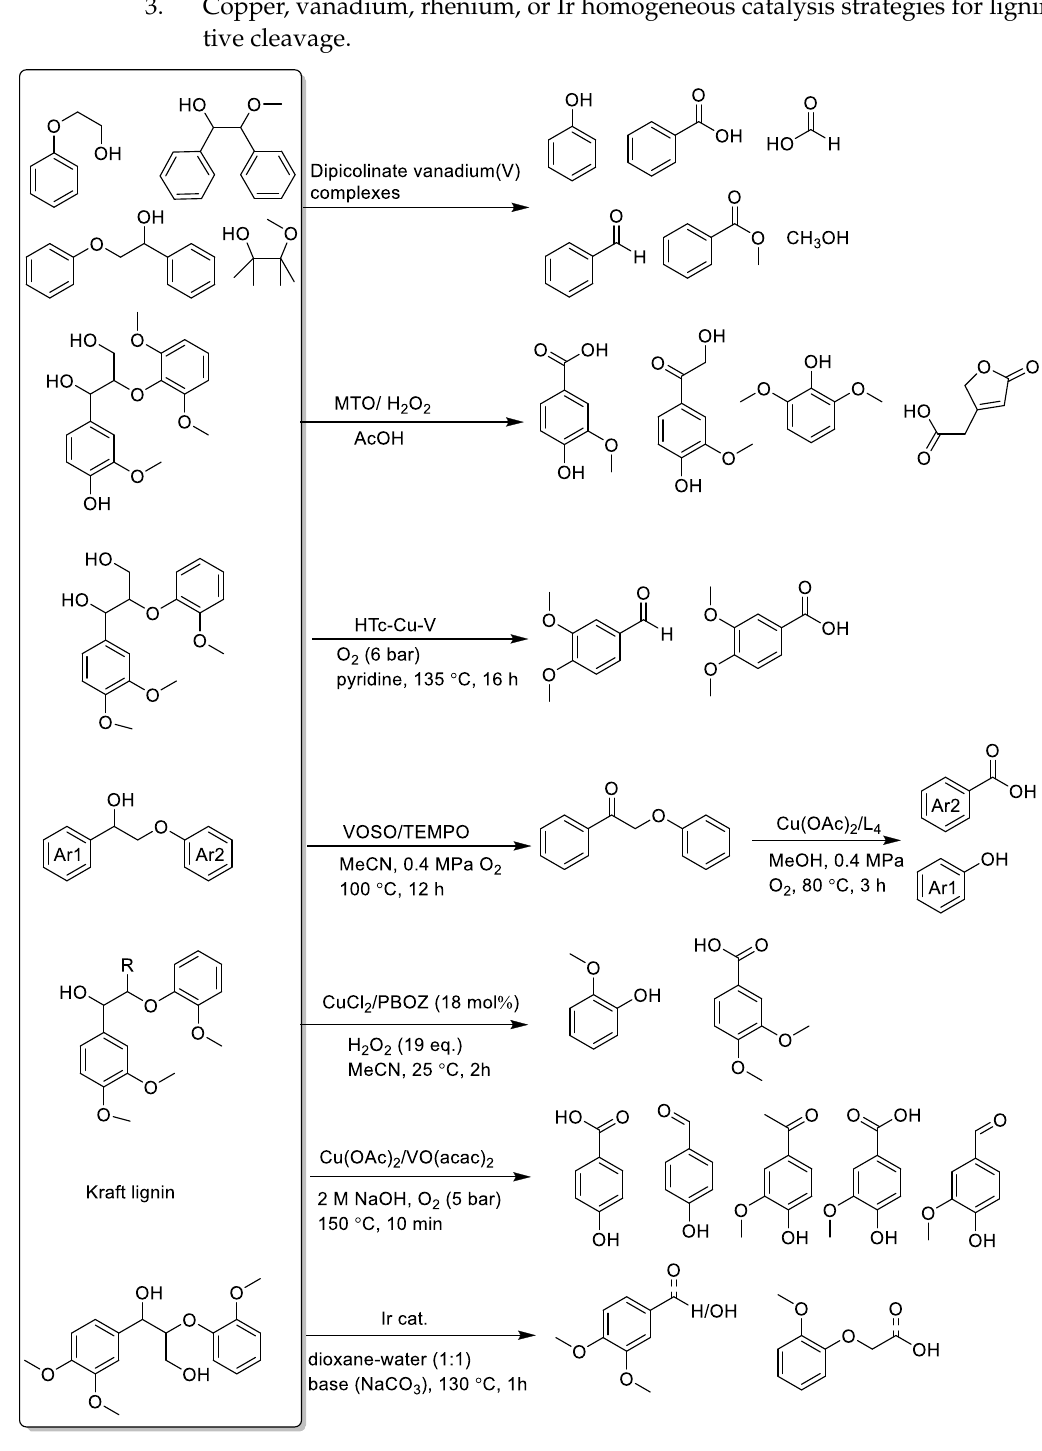
4. Heterogeneous catalysis strategy for lignin oxidative cleavage. 12. Non-Aromatic Acids Lignin is composed of three phenylpropane units on the aromatic rings, named p -hydroxyphenyl (H), guaiacyl (G), and syringyl (S) units [140]. These units are abundant in methoxy substituents on aromatic rings. The use of a strong oxidation system to break aromatic rings to produce low-carbon acids is